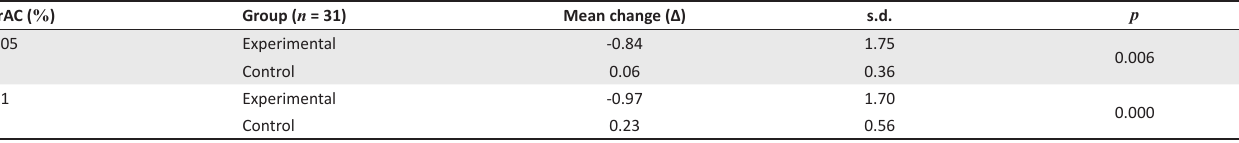
TABLE 2: Mean change in horizontal heterophoria at near for blood respiratory alcohol concentration of 0.05 % and 0.10 % . BrAC ( % ) Group ( n = 31) Mean change (∆) s.d. p 0.05